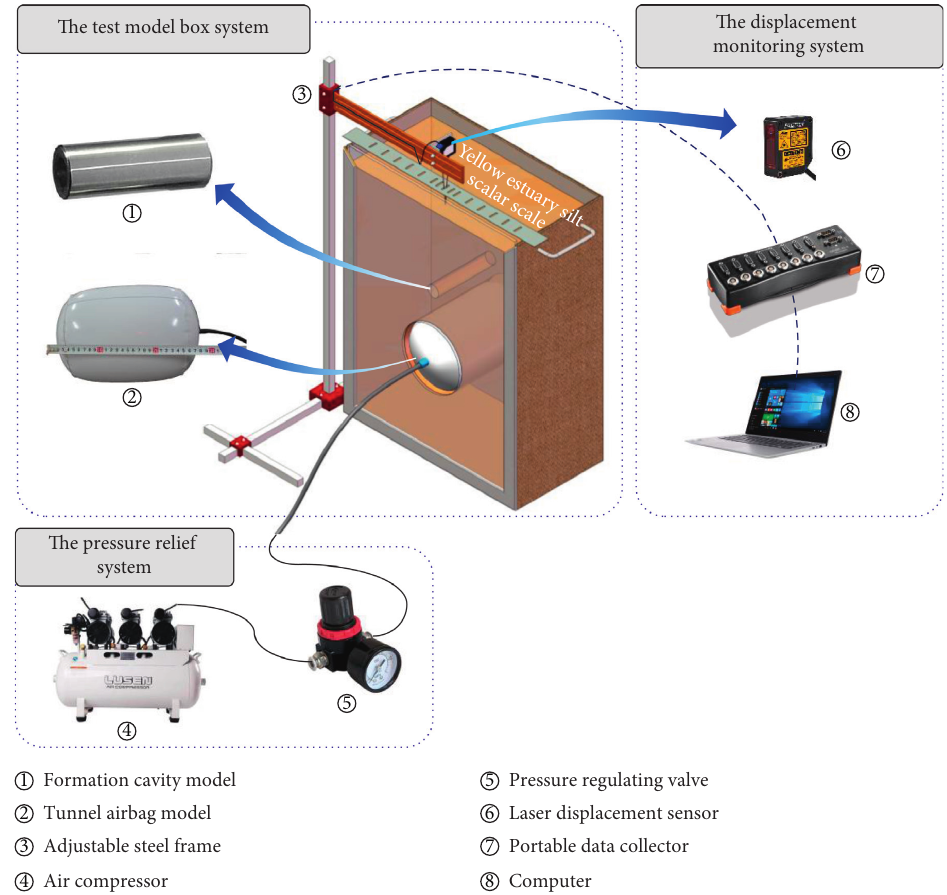
Figure 2: Indoor model test system diagram.